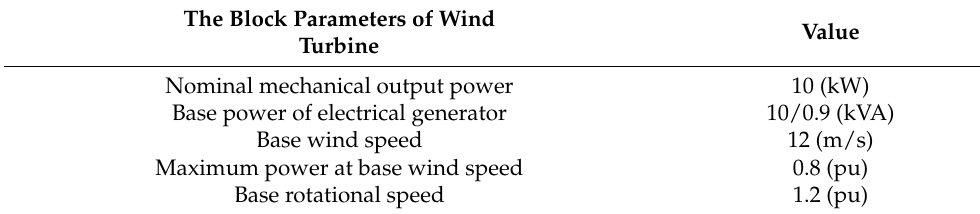
Table 3. The block parameters of the designed wind turbine.